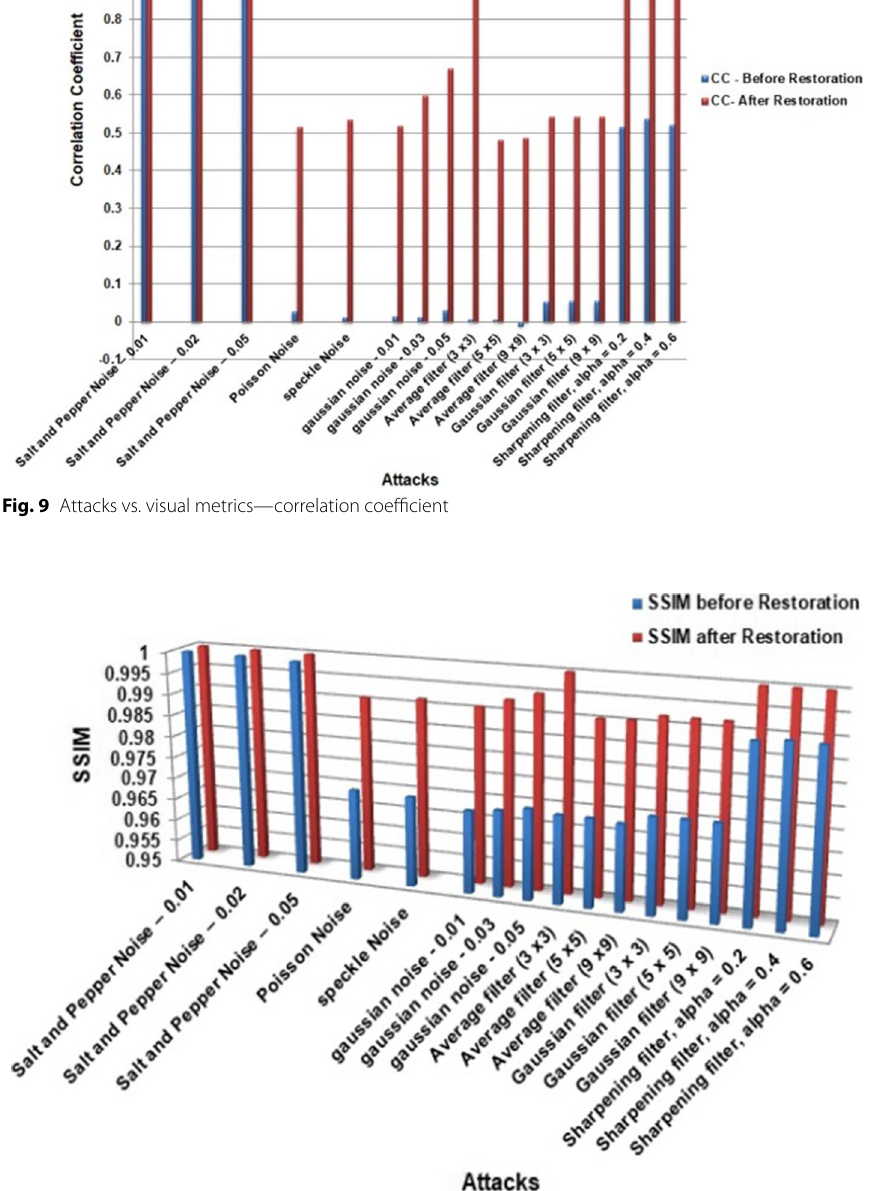
Fig. 10 Attacks vs. visual